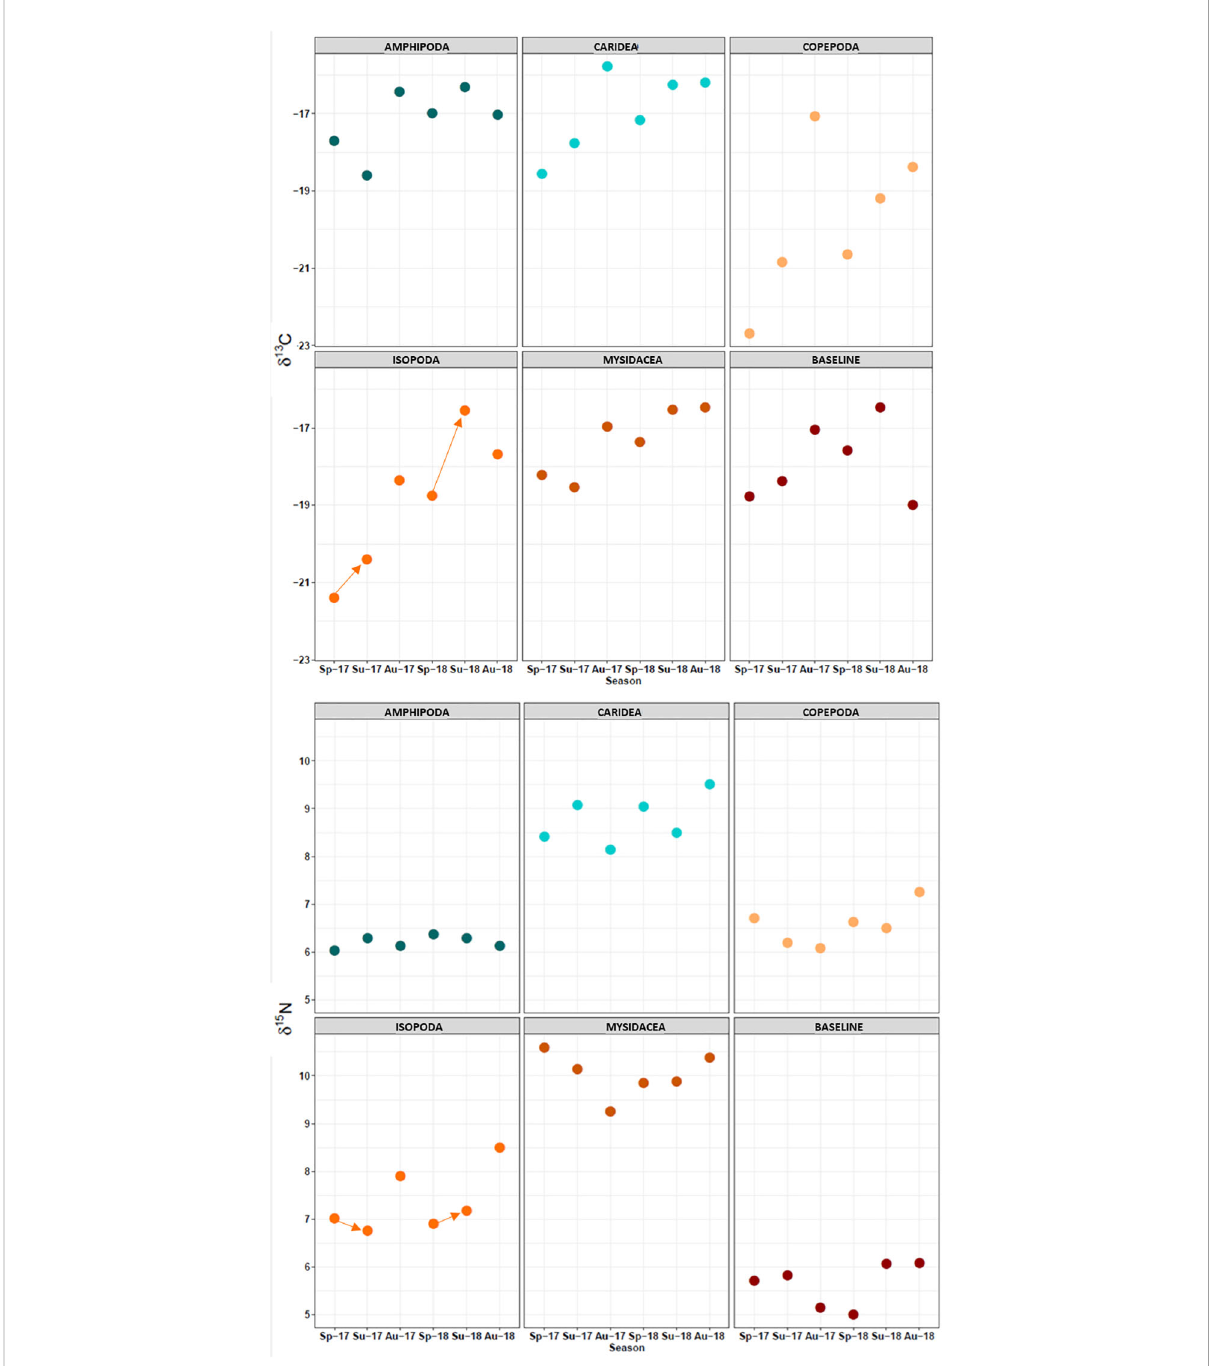
FIGURE 7 Seasonal changes in d 13 C and d 15 N values for dietary resources. Arrows: Change from spring to summer values for